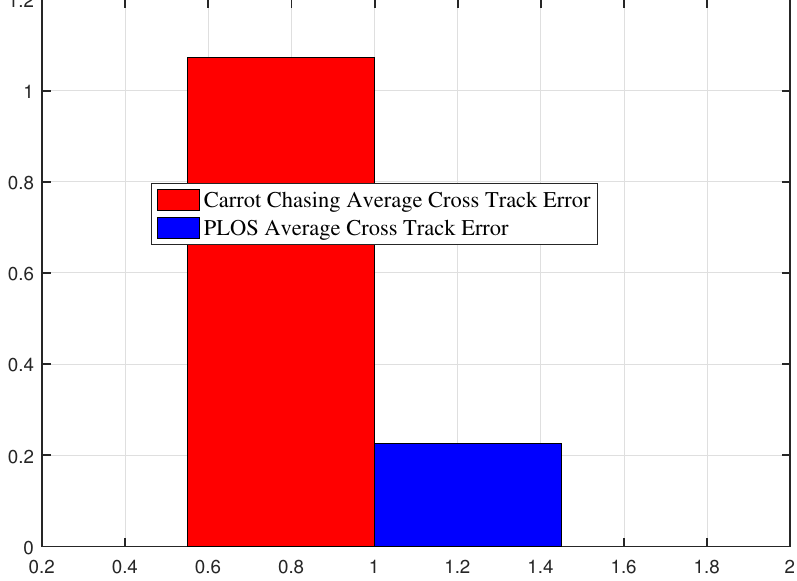
Figure 28. Mean of absolute cross-track error for carrot chasing and PLOS path following guidance